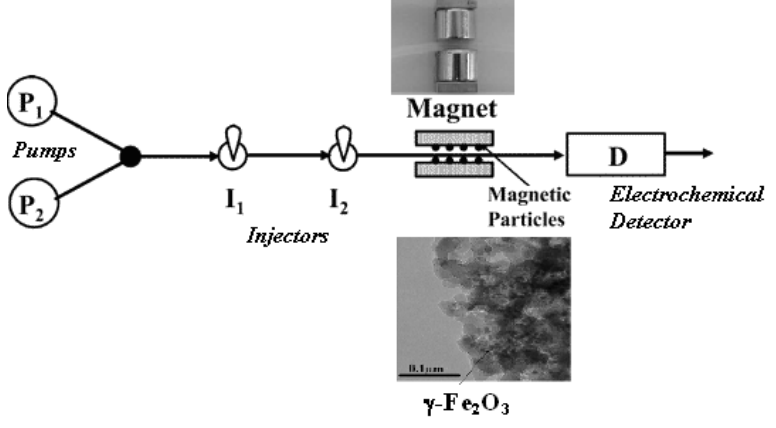
Figure 2. Schematic diagram of a magnetic microflow system based on GOx functionalized biomagnetic particles with electrochemical detection for the detection of glucose (adapted from reference [161] with permission from the American Chemical